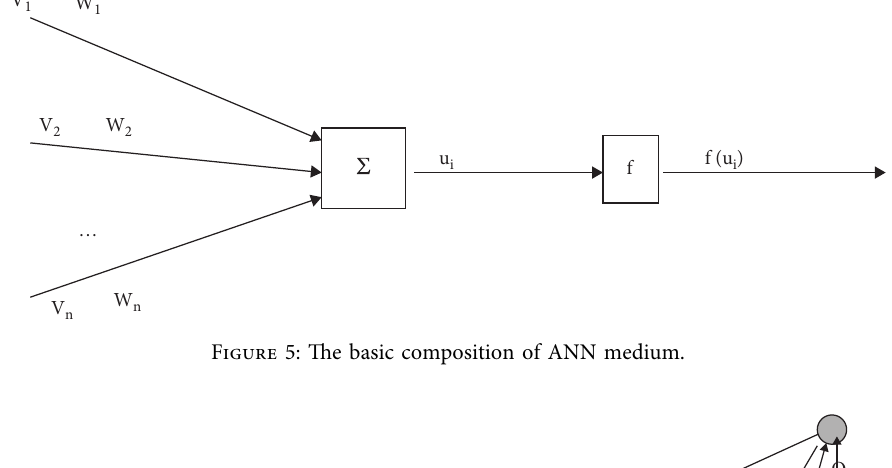
Figure 5: The basic composition of ANN medium.